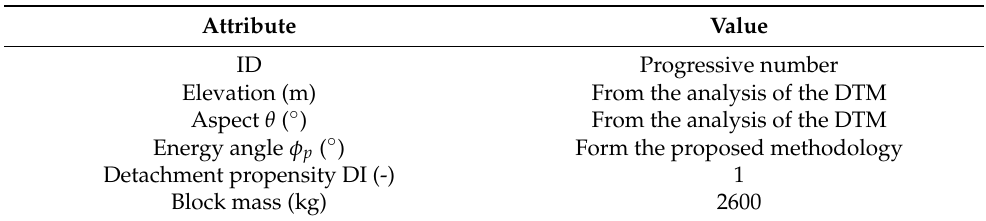
Table 5. Attributes associated to each source point.